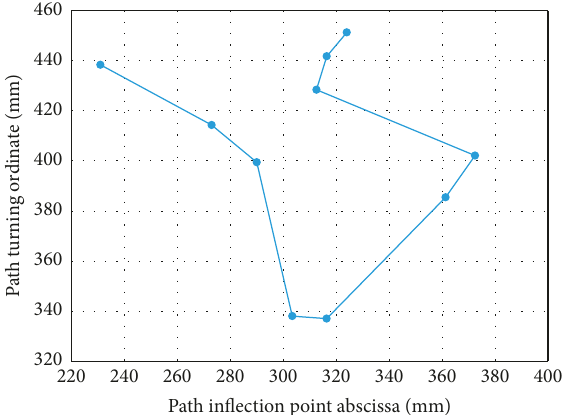
Figure 9: The optimized shortest path connection graph.